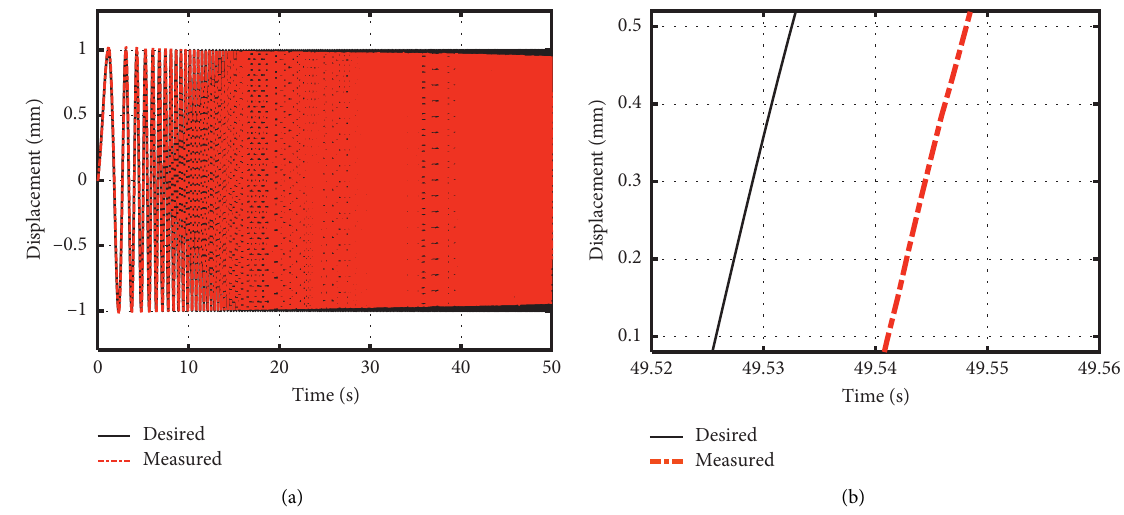
Figure 5: Time histories of commanded and measured swept displacements. (a) Global view. (b) Close-up